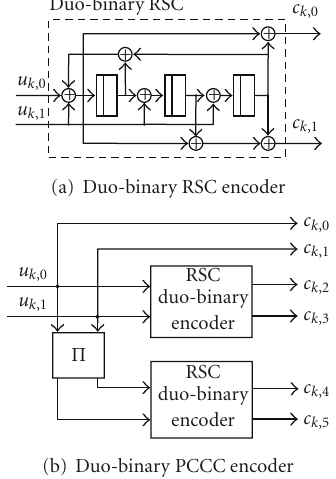
Figure 3: The WiMAX turbo encoder.